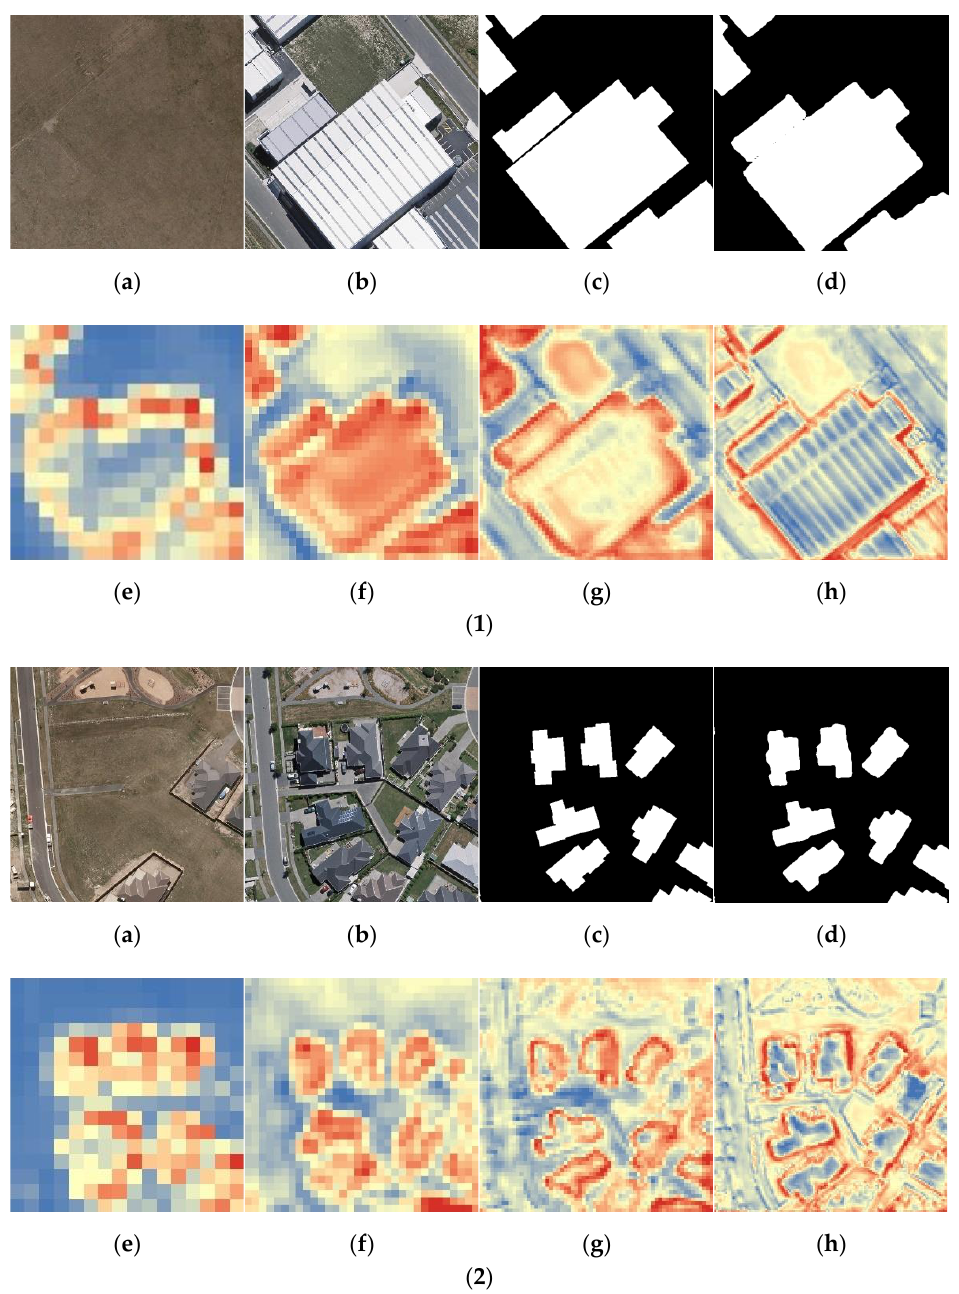
Figure 6. ( 1 ) and ( 2 ) are two different examples; the difference being that buildings were also present in the pretemporal image in ( 2 )( a ). In the two groups, ( a ) and ( b ) show pre- and post-temporal images, respectively; ( c ) and ( d ) show the change ground truth and predicted result, respectively, where white represents the buildings and black represents the background. ( e – h ) Feature difference attention maps at 4 scales (16 × 16, 32 × 32, 64 × 64, and 128 × 128 pixels), in which blue to red represents enhancement from weak to strong.